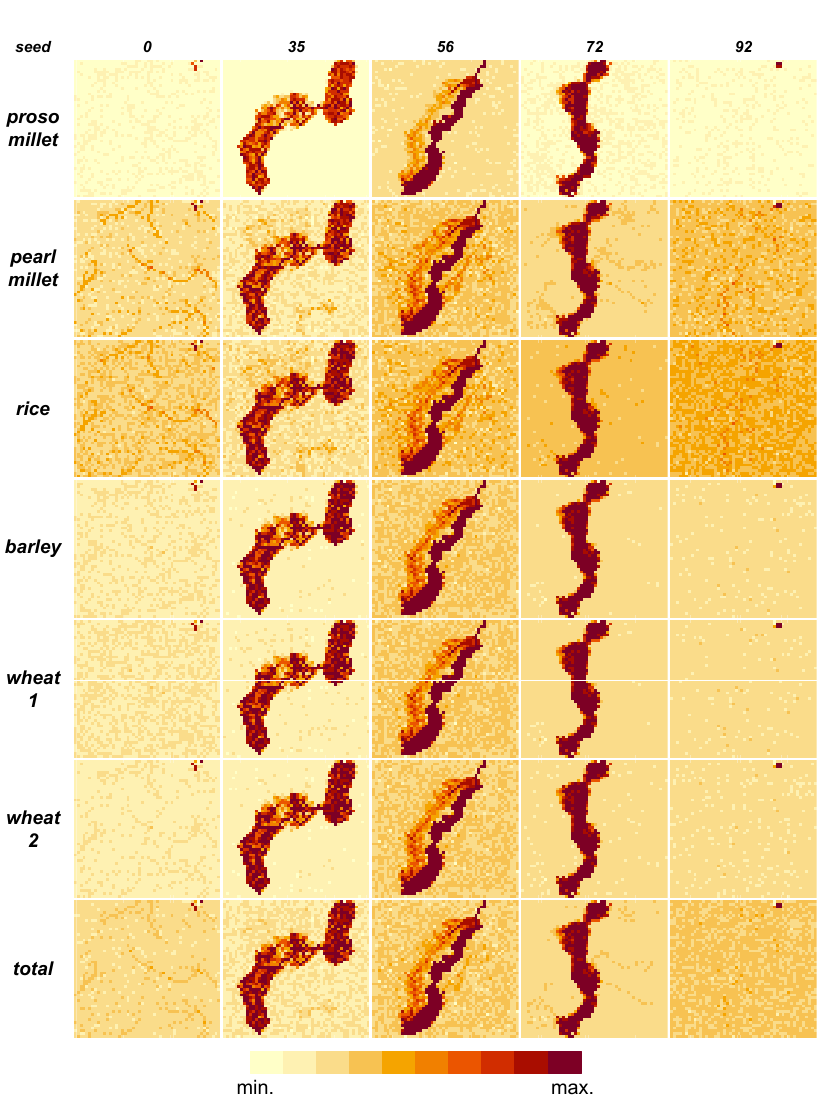
Figure 8. Mean yield spatial distribution (per crop and total) for each terrain in experiment 3. Color saturation gradient represents the interval between case-wise minimum and maximum yield.